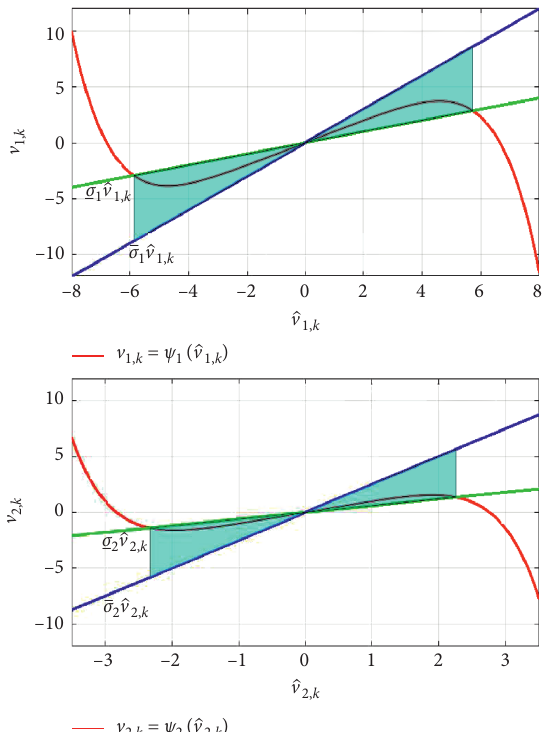
Figure 5: Evolution of nonlinear functions. Up Polt: v